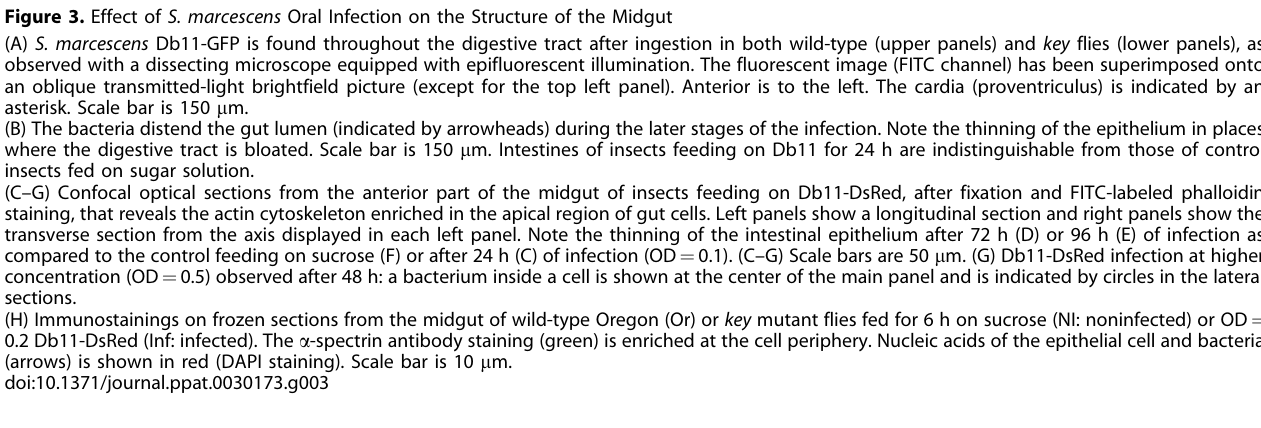
Figure 3. Effect of S. marcescens Oral Infection on the Structure of the Midgut (A) S. marcescens Db11-GFP is found throughout the digestive tract after ingestion in both wild-type (upper panels) and key flies (lower panels), as observed with a dissecting microscope equipped with epifluorescent illumination. The fluorescent image (FITC channel) has been superimposed onto an oblique transmitted-light brightfield picture (except for the top left panel). Anterior is to the left. The cardia (proventriculus) is indicated by an asterisk. Scale bar is 150 l m. (B) The bacteria distend the gut lumen (indicated by arrowheads) during the later stages of the infection. Note the thinning of the epithelium in places where the digestive tract is bloated. Scale bar is 150 l m. Intestines of insects feeding on Db11 for 24 h are indistinguishable from those of control insects fed on sugar solution. (C–G) Confocal optical sections from the anterior part of the midgut of insects feeding on Db11-DsRed, after fixation and FITC-labeled phalloidin staining, that reveals the actin cytoskeleton enriched in the apical region of gut cells. Left panels show a longitudinal section and right panels show the transverse section from the axis displayed in each left panel. Note the thinning of the intestinal epithelium after 72 h (D) or 96 h (E) of infection as compared to the control feeding on sucrose (F) or after 24 h (C) of infection (OD ¼ 0.1). (C–G) Scale bars are 50 l m. (G) Db11-DsRed infection at higher concentration (OD ¼ 0.5) observed after 48 h: a bacterium inside a cell is shown at the center of the main panel and is indicated by circles in the lateral sections. (H) Immunostainings on frozen sections from the midgut of wild-type Oregon (Or) or key mutant flies fed for 6 h on sucrose (NI: noninfected) or OD ¼ 0.2 Db11-DsRed (Inf: infected). The a -spectrin antibody staining (green) is enriched at the cell periphery. Nucleic acids of the epithelial cell and bacteria (arrows) is shown in red (DAPI staining). Scale bar is 10 l m.